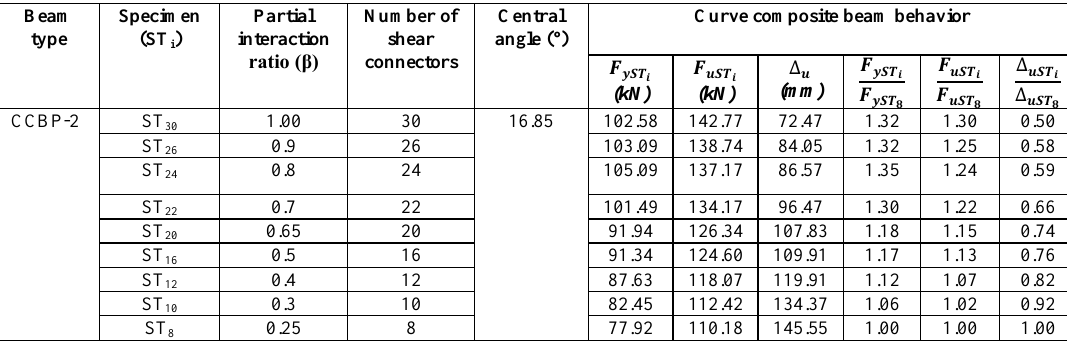
Table 6. Partial interaction effect on the curved composite